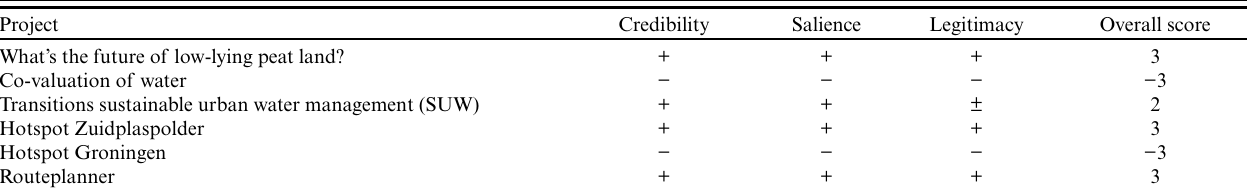
Table 5. Project scores for credibility, salience, and legitimacy.†